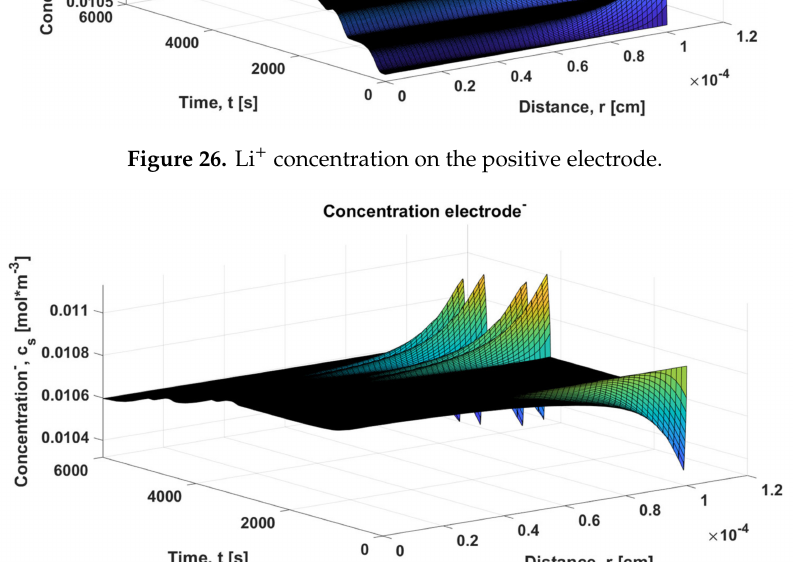
Figure 27. Li + concentration on the negative